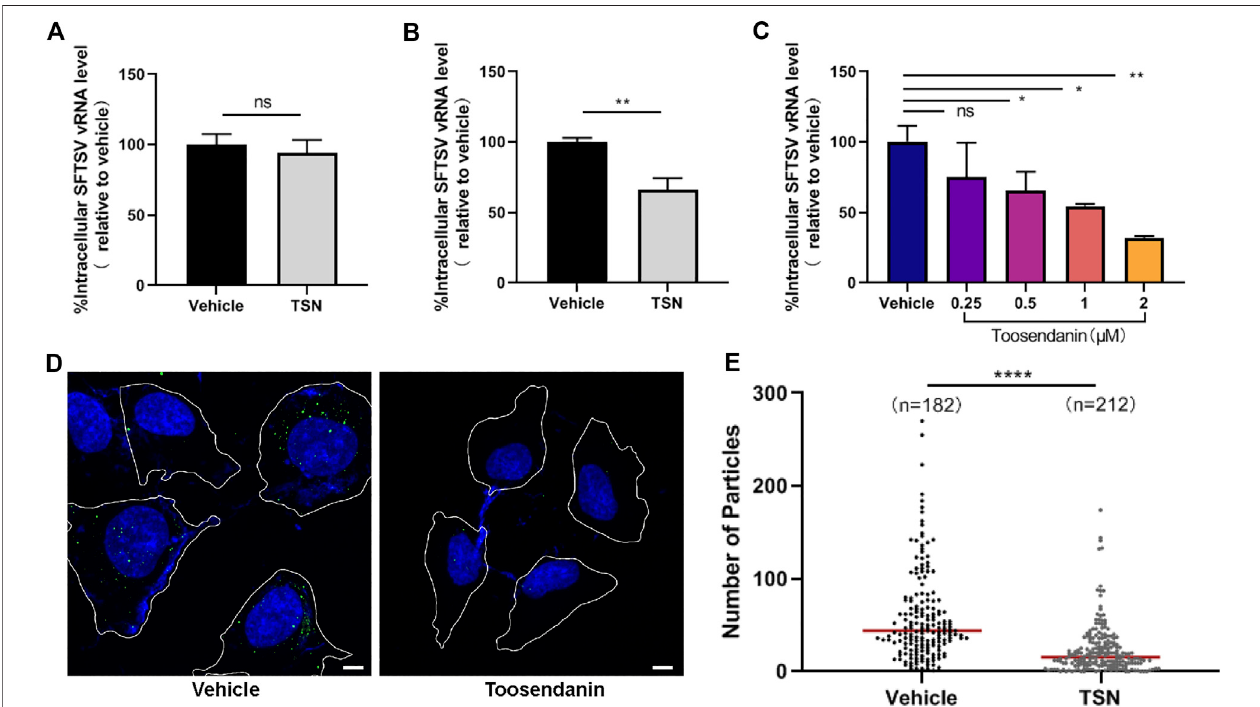
FIGURE 4 | Toosendanin inhibits SFTSV internalization. (A) Effect of toosendanin on SFTSV binding. HUVEC cells were pretreated with toosendanin (1 μ M) or vehicle (DMSO) at 37 ° C for 1 h, chilled at 4 ° C for 15 min, and incubated with SFTSV (MOI (cid:1) 5) at 4 ° C for 2 h. The unbound virions were removed with pre-cooled PBS, and cells were harvested for bound virions quanti fi cation. (B,C) Effect of toosendanin on SFTSV internalization. HUVEC cells pre-treated with 1 μ M toosendanin (B) or a seriesconcentrationof toosendanin (C) for 1 h werechilled at 4 ° C for 15 min and incubated with SFTSV(MOI (cid:1) 5) for1 h. Cells werewashed withpre-cooled PBS toeliminatetheunboundvirions andincubated at37 ° Cfor3 hinthepresenceofammonium chloride(20 mM),thenwashedand treatedwithtrypsin.Therelativelevelof internalizedvirionswasdeterminedbyqRT-PCR. (D) EffectoftoosendaninonSFTSVinternalizationwasanalyzedbyimmuno fl uorescence.Cellboundaries(whitelines), NP staining (green), DAPI staining (blue). Bars represent 5 μ m. (E) Quanti fi cation of intracellular virions captured in (D) . Median value (red line), number of cells under quanti fi cation (n). TSN, toosendanin. Data shown are means ± SD ( n (cid:1) 3). Comparison of mean values (A,B,C) between two groups were analyzed by Student ’ s t test. * p < 0.05; ** p < 0.01; ns, no signi fi cance. Comparison of median values (E) between two groups were analyzed by Mann-Whitney test. **** p <